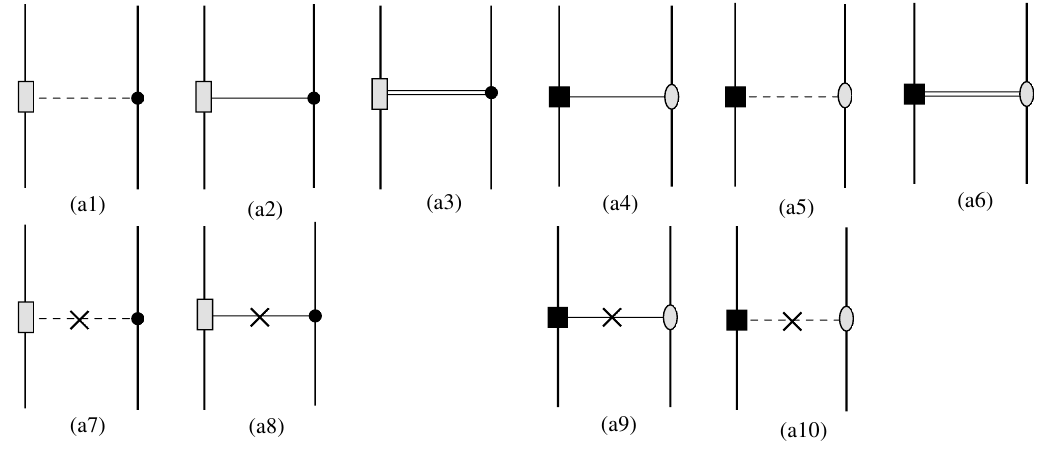
Figure 2 . The Feynman graphs of one-graviton exchange, which contribute to the NLO cubic-in- spin interaction at the 4.5PN order for maximally rotating compact objects. The graphs should be included together with their mirror images, i.e. with the worldline labels 1 ↔ 2 exchanged. At the linear level of one-graviton exchange we only have two kinds of interactions contributing, similar to the LO in [11], namely either a quadrupole-dipole or an octupole-monopole interaction. As noted in [11] there are nice analogies among these interactions according to the parity of the multipole moments involved. Following these analogies the relevant graphs here are easily constructed. Notice that we have here the four graphs that appeared at the LO with the quadratic time insertions on the propagators at graphs (a7)–(a10), and a new octupole coupling involving the KK tensor field at graph